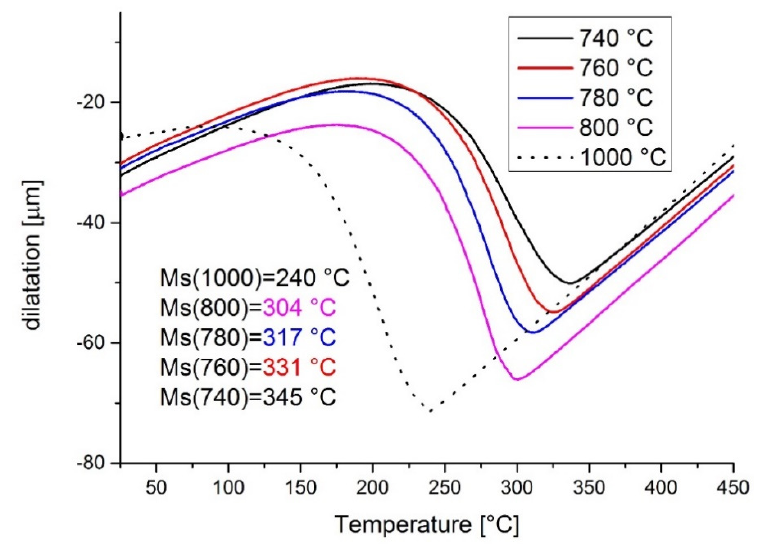
Figure 4. Dilatation curves upon quenching from different intercritical annealing temperatures with martensite start (Ms) temperatures.